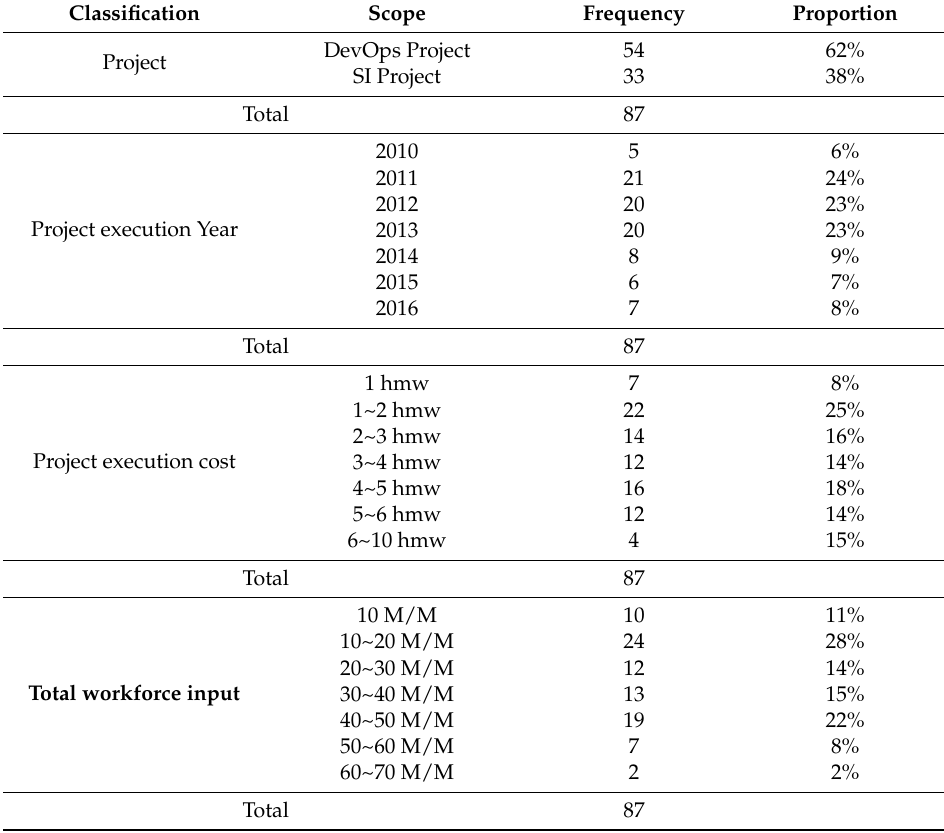
Table 4. The summary of manufacturing IT project sample data